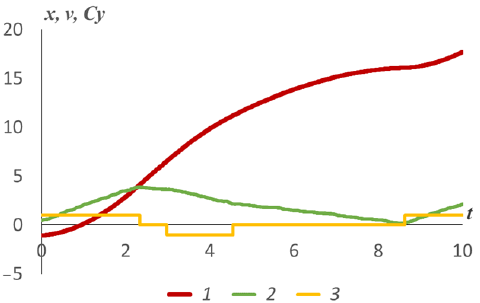
Figure 6. Typical trajectory “coordinate–velocity” in the uncontrolled case of the semistable system: 1—coordinate x t ; 2—coordinate v t ; 3—drift Cy t